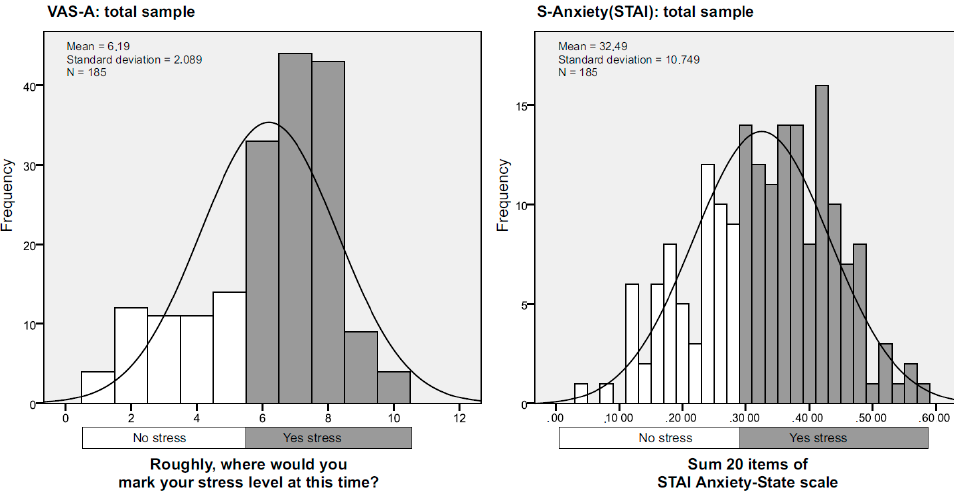
Figure 1. VAS-A and STAI histograms by cut-off point.